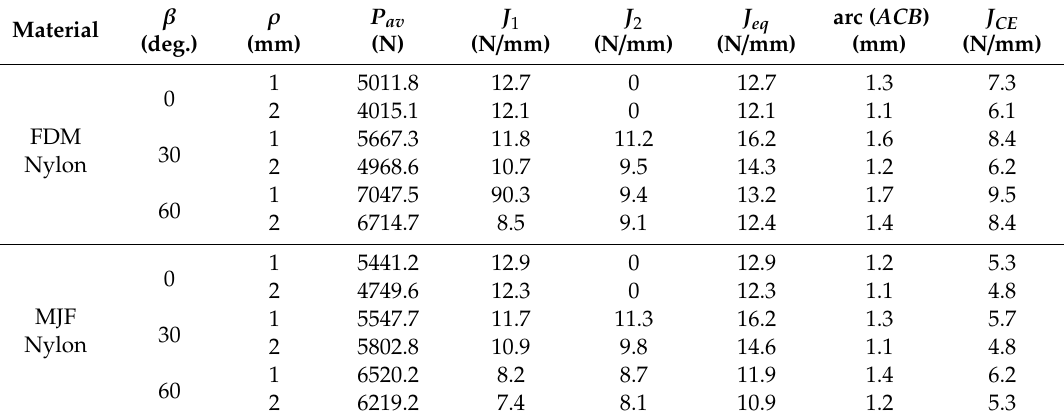
Figure 9. Illustration of strain energy density around the notch border for MJF nylon with a notch tip radius of 2 mm at di ff erent notch orientations. Table 3. Numerical results of 3D-printed U-notched nylon material under mode I and mixed mode I / II loading